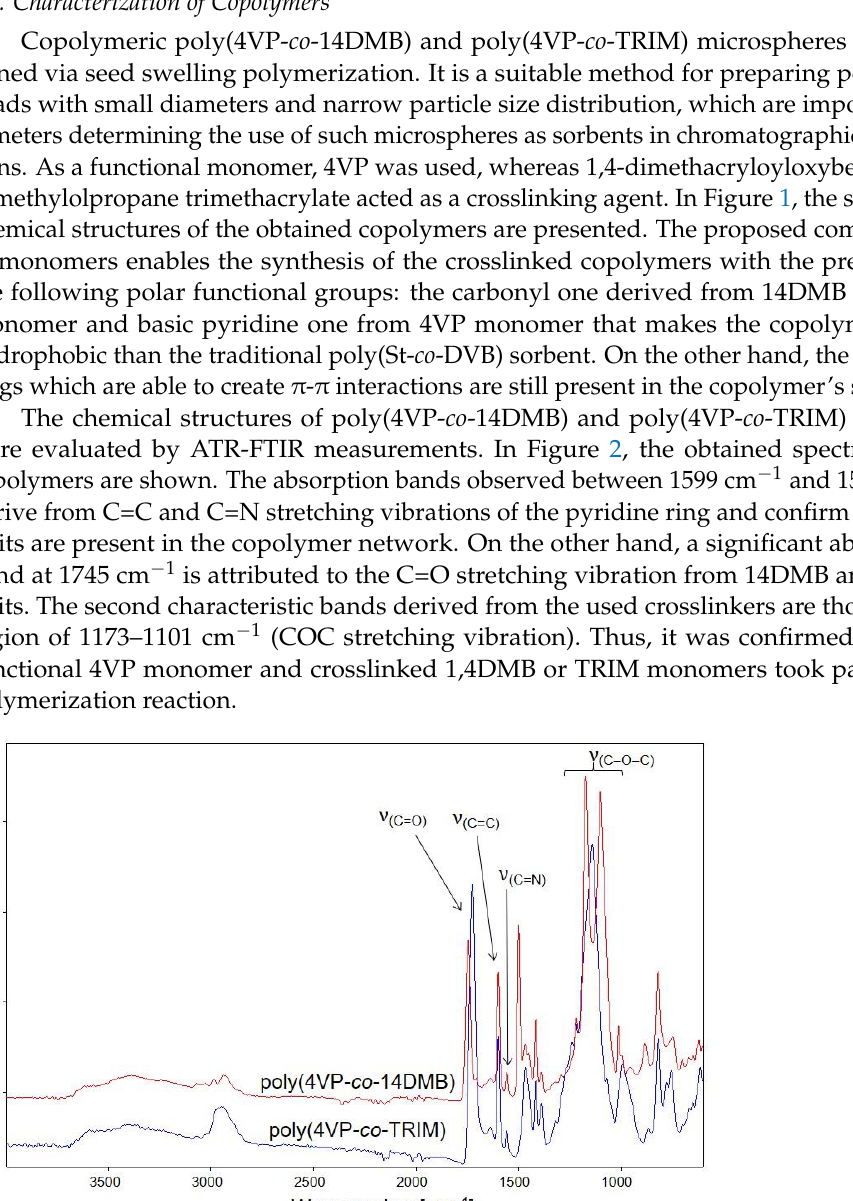
Figure 3. 13 C CP/MAS NMR spectrum of poly(4VP- co -14DMB). The morphology of poly(4VP- co -14DMB) and poly(4VP- co -TRIM) microspheres was determined by SEM measurements. As is visible in Figure 4 presenting the SEM images of the synthesized copolymers, the particles possess an ideal spherical shape. Their num- ber average diameter is 8.18 µm with a CV of 4.22% for poly(4VP- co -14DMB) and 9.25 µm with a CV of 9.83% for poly(4VP- co -TRIM). A CV value lower than 10% indicates that the microspheres are nearly uniform in size. For TRIM crosslinked microspheres, the D n value is higher than for those synthesized with 14DMB. The chemical structure of TRIM is more expanded than that of 14DMB, and TRIM possesses three methacrylate groups that can react during polymerization with 4VP. This probably explains why upon the following same polymerization conditions: molar ratio of monomers, amount of PS seed, and tolu- ene, the microspheres produced from TRIM are of higher diameter than those obtained with 14DMB. In addition, images of poly(St- co -DVB) microspheres are presented in Figure 4. These microspheres were obtained as reference materials with a highly hydrophobic nature.